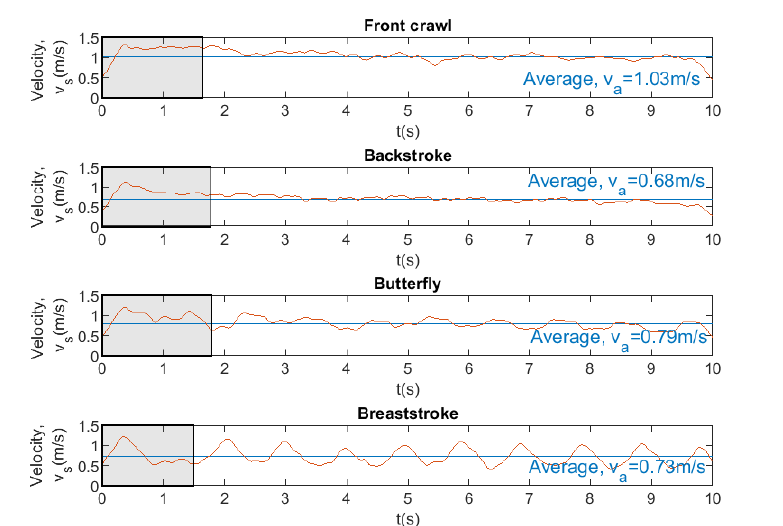
Figure 14. Instantaneous and average velocity for four swimming strokes. Brake force = 68.41